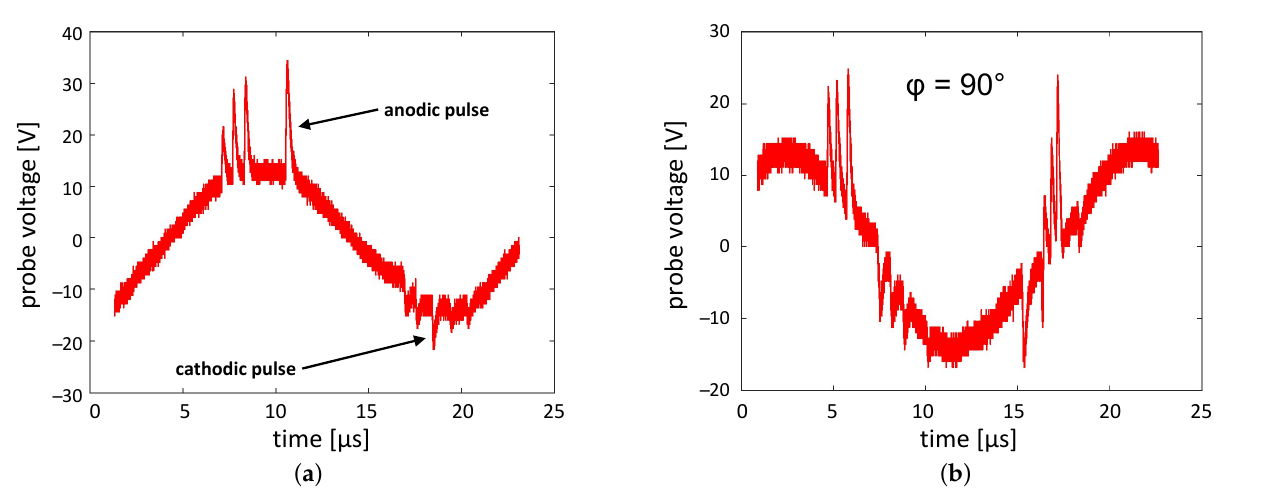
Figure 3. The probe voltage measured for: ( a ) single PCPG, and ( b ) two PCPGs placed parallel at a tip-to-tip distance of 60 mm, operated with the input power of 8.0 W and the CDA flow of 8 SLM each. The distance between the PCPG tip and the probe surface is 30